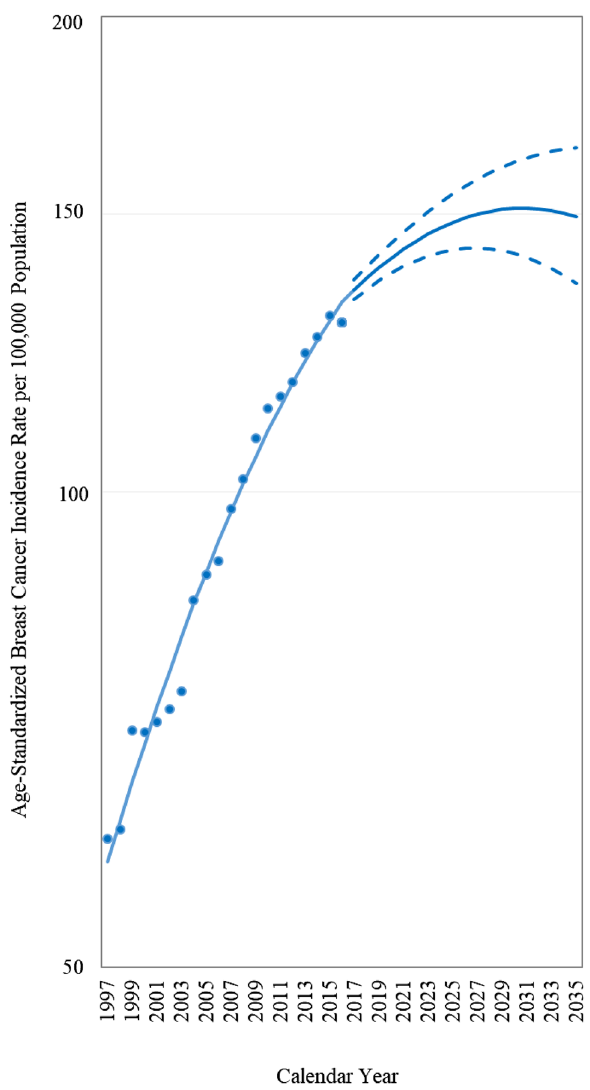
Figure 1. Age-standardized breast cancer incidence rate from 1997 to 2016 and projection from 2017 to 2035. The World Health Organization’s 2000 World Standard Populations were used to compute the truncated age-standardized incidence rate (age range 25 + years). Dotted lines indicate 95% confidence intervals for the